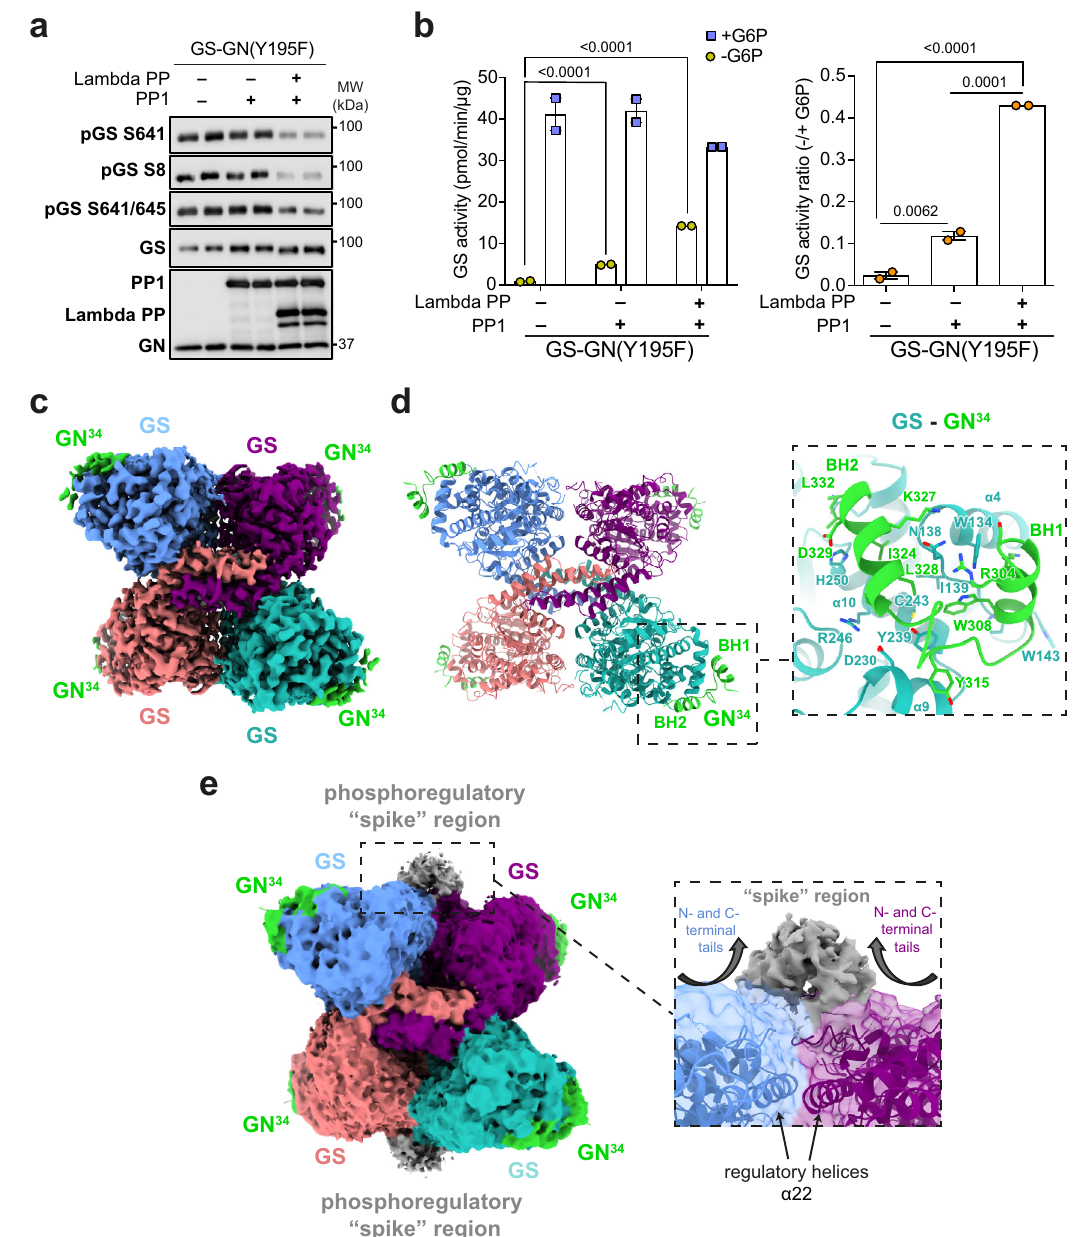
Fig. 2 Cryo-EM structure of human GS-GN 34 complex. a Immunoblot for the indicated human GS phosphorylation sites and total GS. Data are representative of two independent experiments carried out in technical duplicates. b Activity of GS-GN(Y195F) with and without the addition of lambda protein phosphatase (lambda PP) and protein phosphatase 1 (PP1) (left) and − / + G6P activity ratio (right). Upon G6P saturation, GS reaches similar activity levels regardless of phosphorylation state. Data are mean ± S.E.M. from n = 2 and representative of two independent experiments. One-way analysis of variance (Tukey ’ s post hoc test); exact p values are shown. Source data for ( a and b ) are provided as a Source Data fi le. c 2.6 Å cryo-EM map of the GS tetramer coloured by corresponding chain. Density corresponding to the GN 34 C-terminal region is shown in green. d Human GS-GN 34 cartoon model shown in ribbons coloured by corresponding chain (left). Interaction between GS and GN 34 (right). e Unsharpened cryo-EM map shown at a lower threshold to visualise the “ spike ” region depicted in grey (left). The N- and C-terminal tails of two protomers converge and form the “ spike ” region adjacent GS protomer (chain B), which has travelled from the This allows chain B to engage with the regulatory helices α 22, opposite direction (Fig. 3a, right panels). A 2.8 Å cryo-EM map of speci fi cally phosphorylated S641 interacting with residues R588 GS generated without the application of D2 symmetry averaging and R591, which come from two GS protomers to form a posi- (EMDB-14587) (Supplementary Fig. 6a, b), suggests that one tively charged pocket we have termed the “ arginine cradle ” C-terminal tail disengages with the GS core earlier than the other (Fig. 3a and Supplementary Fig. 7d). This is consistent with our C-terminal tail from the adjacent chain. The C-terminal tail from phosphorylation mapping and immunoblotting data showing chain B continues to travel further across the regulatory helices S641 is phosphorylated in our preparations (Table 1, Supple- than chain A, prior to traversing away from the core (Fig. 3a). mentary Fig. 4b and Fig. 2a).